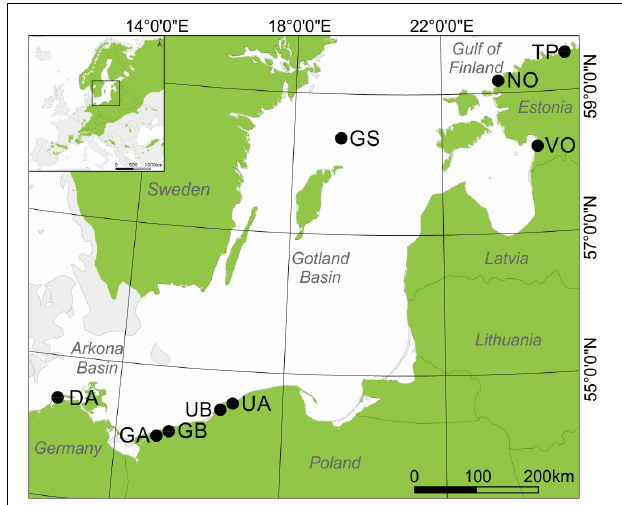
FIGURE 1 | The location of sampling sites around the south Baltic Sea. A small map shows the location of study area and green shading presents Scots pine distribution (www.euforgen.org/species/). Site name abbreviations are explained in Table 1